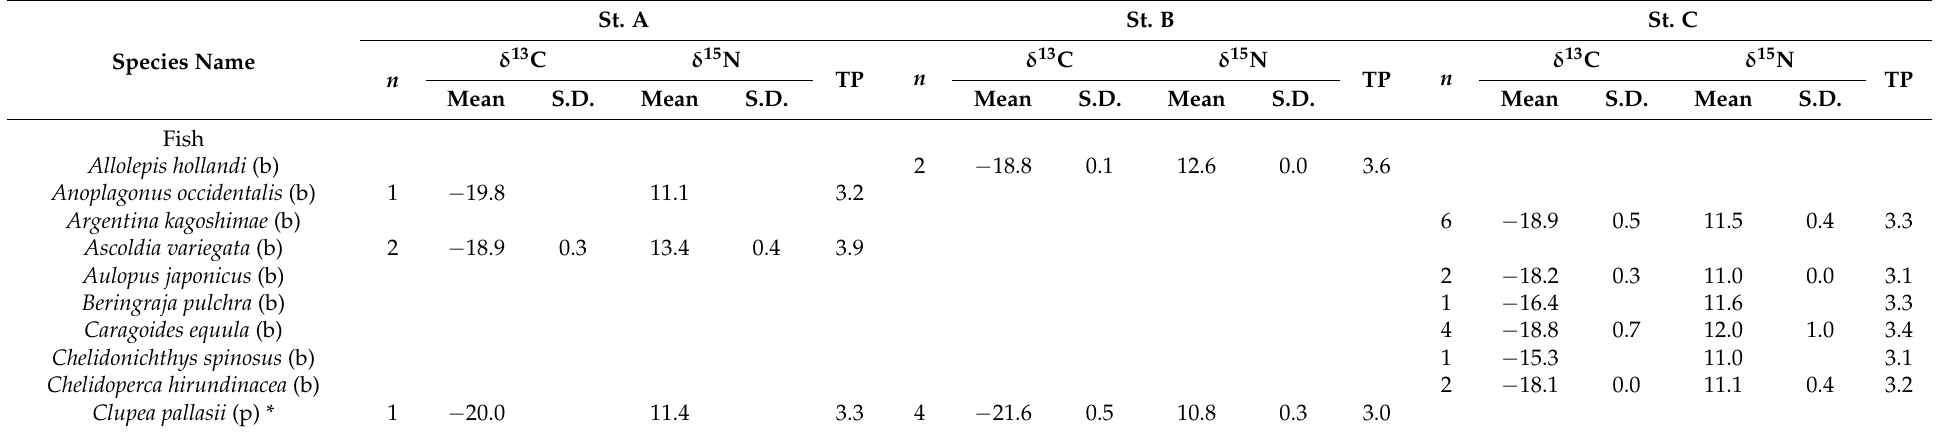
Table 5. δ 13 C and δ 15 N values and trophic position (TP) of fish consumers collected at the St. A, St. B, and St. C during October 2020. Lower case codes indicate feeding modes (b, benthic feeder; bp, benthopelagic feeder; p, pelagic feeder). The lipid-correction was applied for the δ 13 C of marked species (*). Data represent mean ± 1